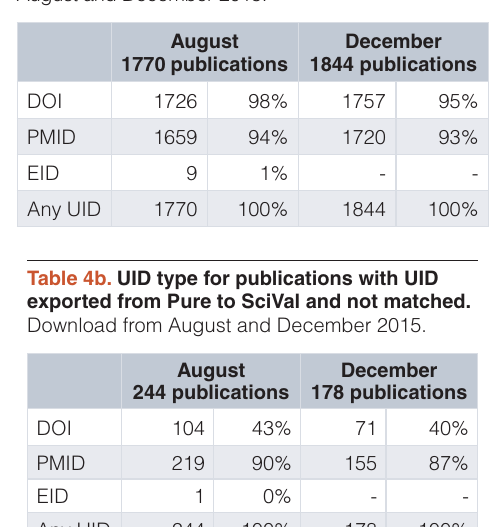
Table 4a. UID type for publications with UID exported from Pure to SciVal and matched. Download from